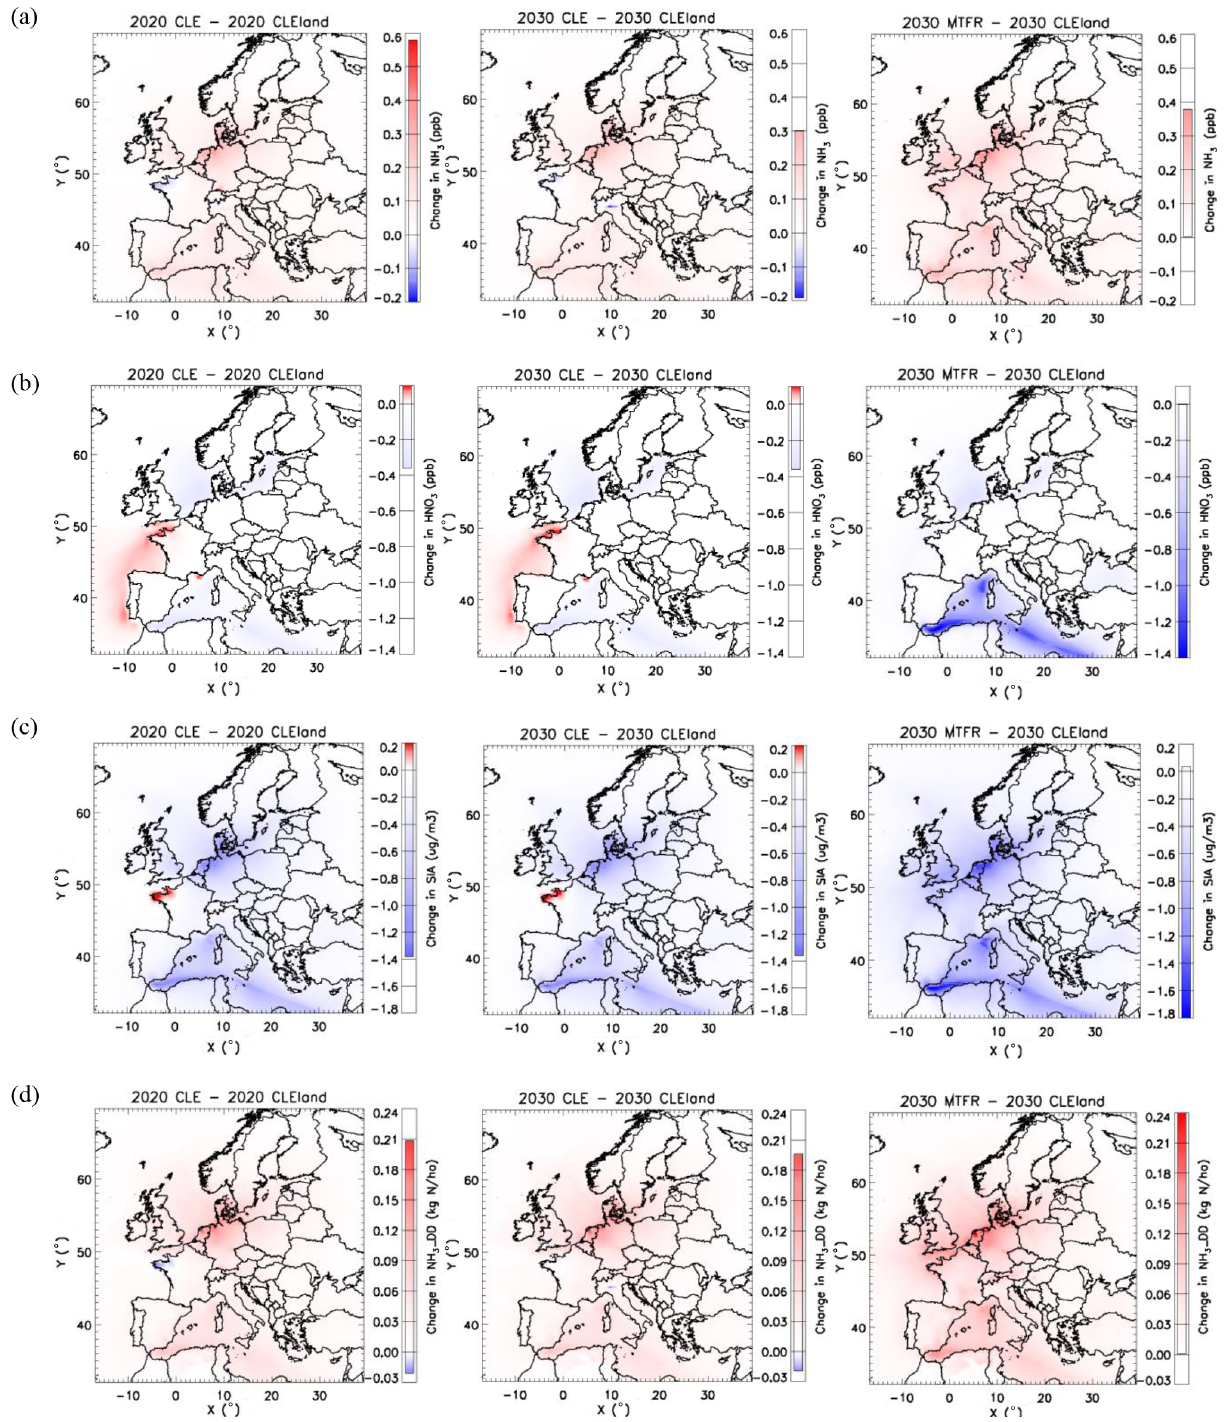
Figure 5. Effect of ship emissions on annual average concentrations of (a) ammonia (ppb), (b) nitric acid (ppb), (c) secondary inorganic aerosols (µgm − 3 ) and (d) dry deposition of ammonia (kgNha − 1 ) in scenarios 2020 CLE (left), 2030 CLE (middle) and 2030 MTFR (right). CLEland: with ship emissions of 2010; CLE: with ship emissions under current legislation; MTFR: with ship emissions under maximum technically feasible